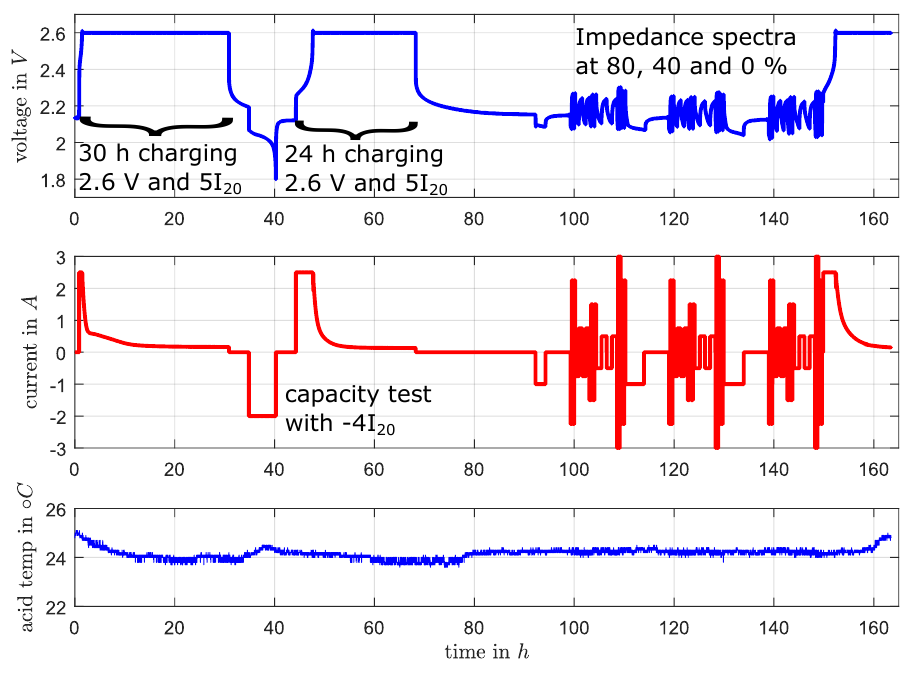
Figure 2. The voltage, current, and temperature profile of the initial process performed on all test cells before the aging test.